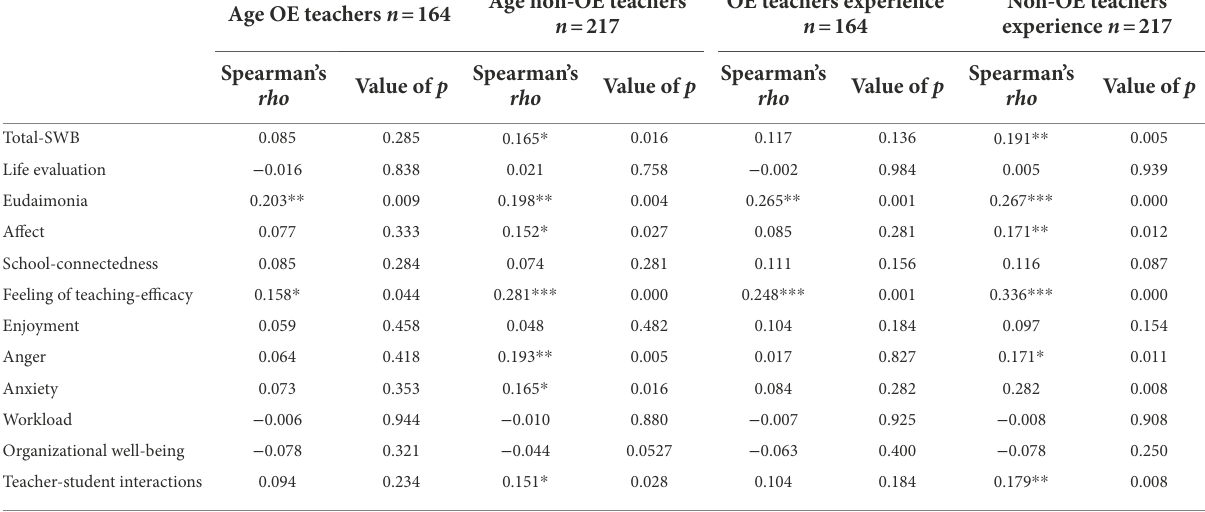
TABLE 4 SWB scores correlations with age and teaching experience.